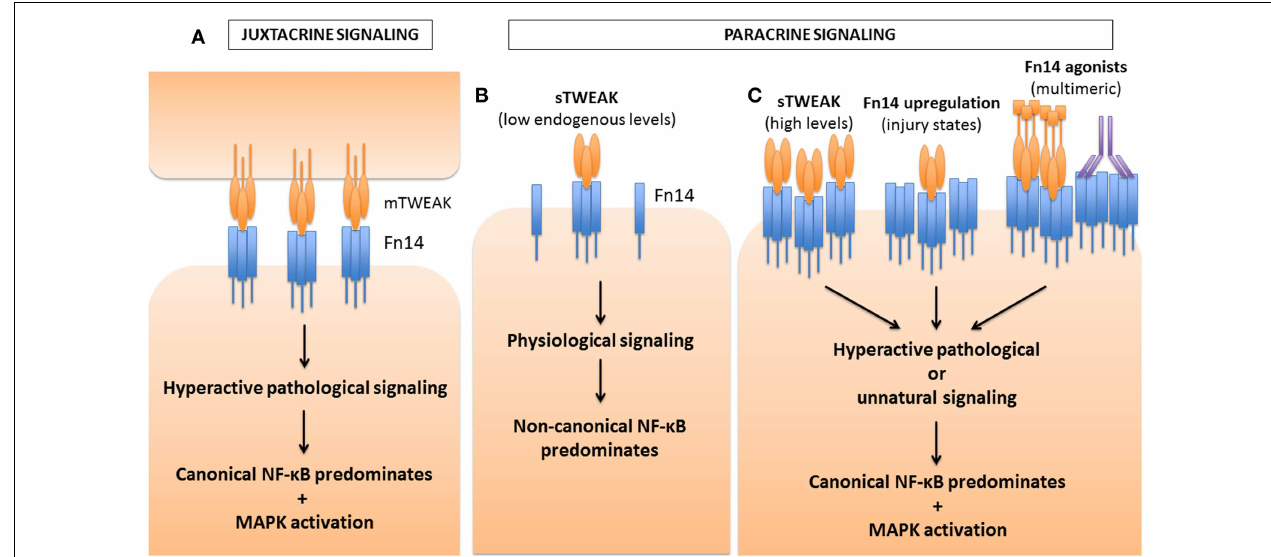
and MAPK signaling. For example, high concentrations ofTWEAK, applied to myoblasts or myotubes ex vivo , hinder differentiation and cause atrophy, respectively.Transgenic over-expression ofTWEAK in mice also leads to pathological consequences. In a variety of injury states (such as denervation-induced muscle atrophy), the receptor Fn14 is induced, which then is followed by and pathological responses to endogenous levels of TWEAK. Furthermore, recombinantTWEAK fusion proteins with the ability to multimerize, or Fn14 agonistic antibodies, can both promote receptor clustering and the activation of the canonical NF- κ B pathway.The pathways leading to pathological activation of the canonical NF- κ B pathway are still poorly defined, but are thought to arise either from pathway cross-talk, such as that seen with NIK or IKK activation of the canonical mediators, or through the adaptor and E3 ubiquitin ligaseTRAF6. In addition, activation of MAPK pathways may also contribute to the pathology